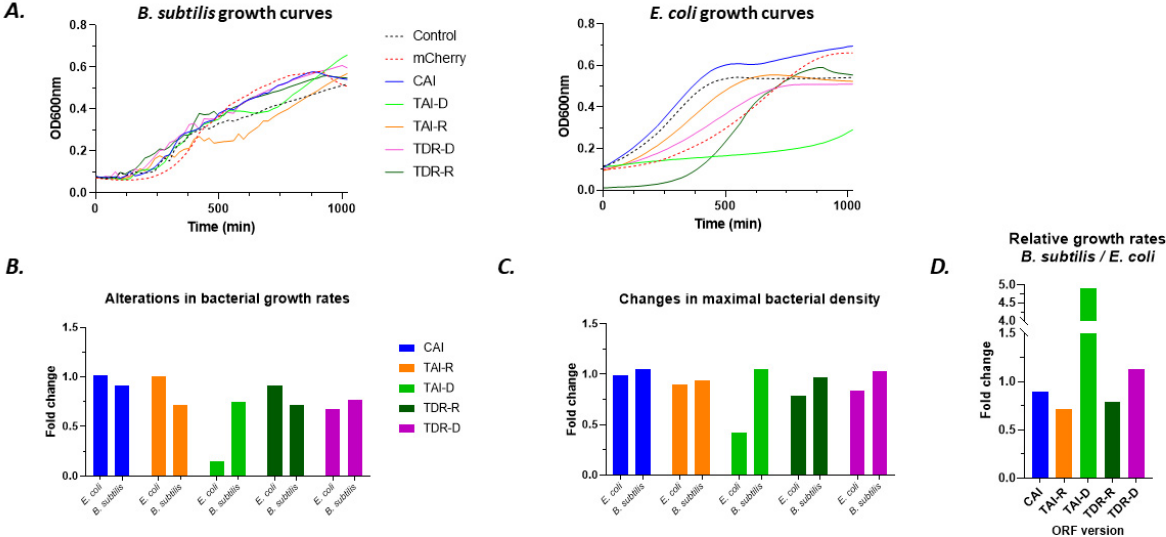
Figure 15. ORF modification alters the growth of deoptimized bacteria (according to optimizations in Table A1): ( A ) representative growth curves for B. subtilis ( left ) and E. coli ( right ). Control (black dashed curve) stands for bacteria containing the same plasmid backbone that lacks the mCherry gene. mCherry (red dashed curve) is the original (unmodified) version of the gene, and CAI, TAI-D, TDA-R, TDR-D, and TDR-R are modified versions of mCherry gene; ( B ) fold change in bacterial growth rates of each ORF version relative to the growth rates in mCherry; ( C ) same as in ( B ) but calculated for the average maximal density; ( D ) fold of growth rates in B. subtilis relative to E. coli.